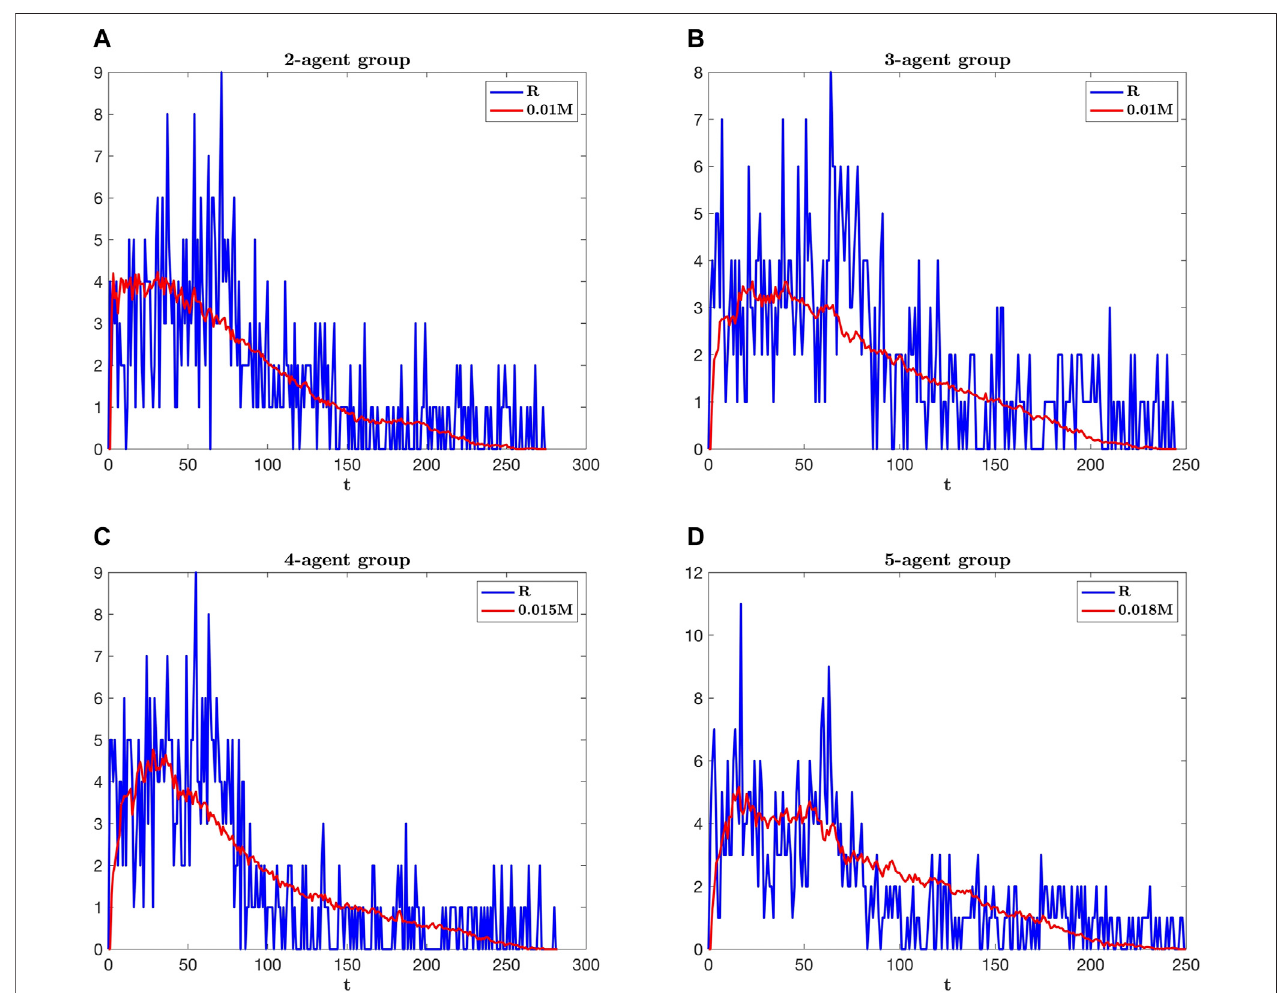
FIGURE 12 | Comparison of R-t (blue) pattern with cM-t (red) pattern (c being the constant scaling factor) for the evacuation of 2-agent group (A) , 3-agent group (B) , 4-agent group (C) , and 5-agent group (D) .